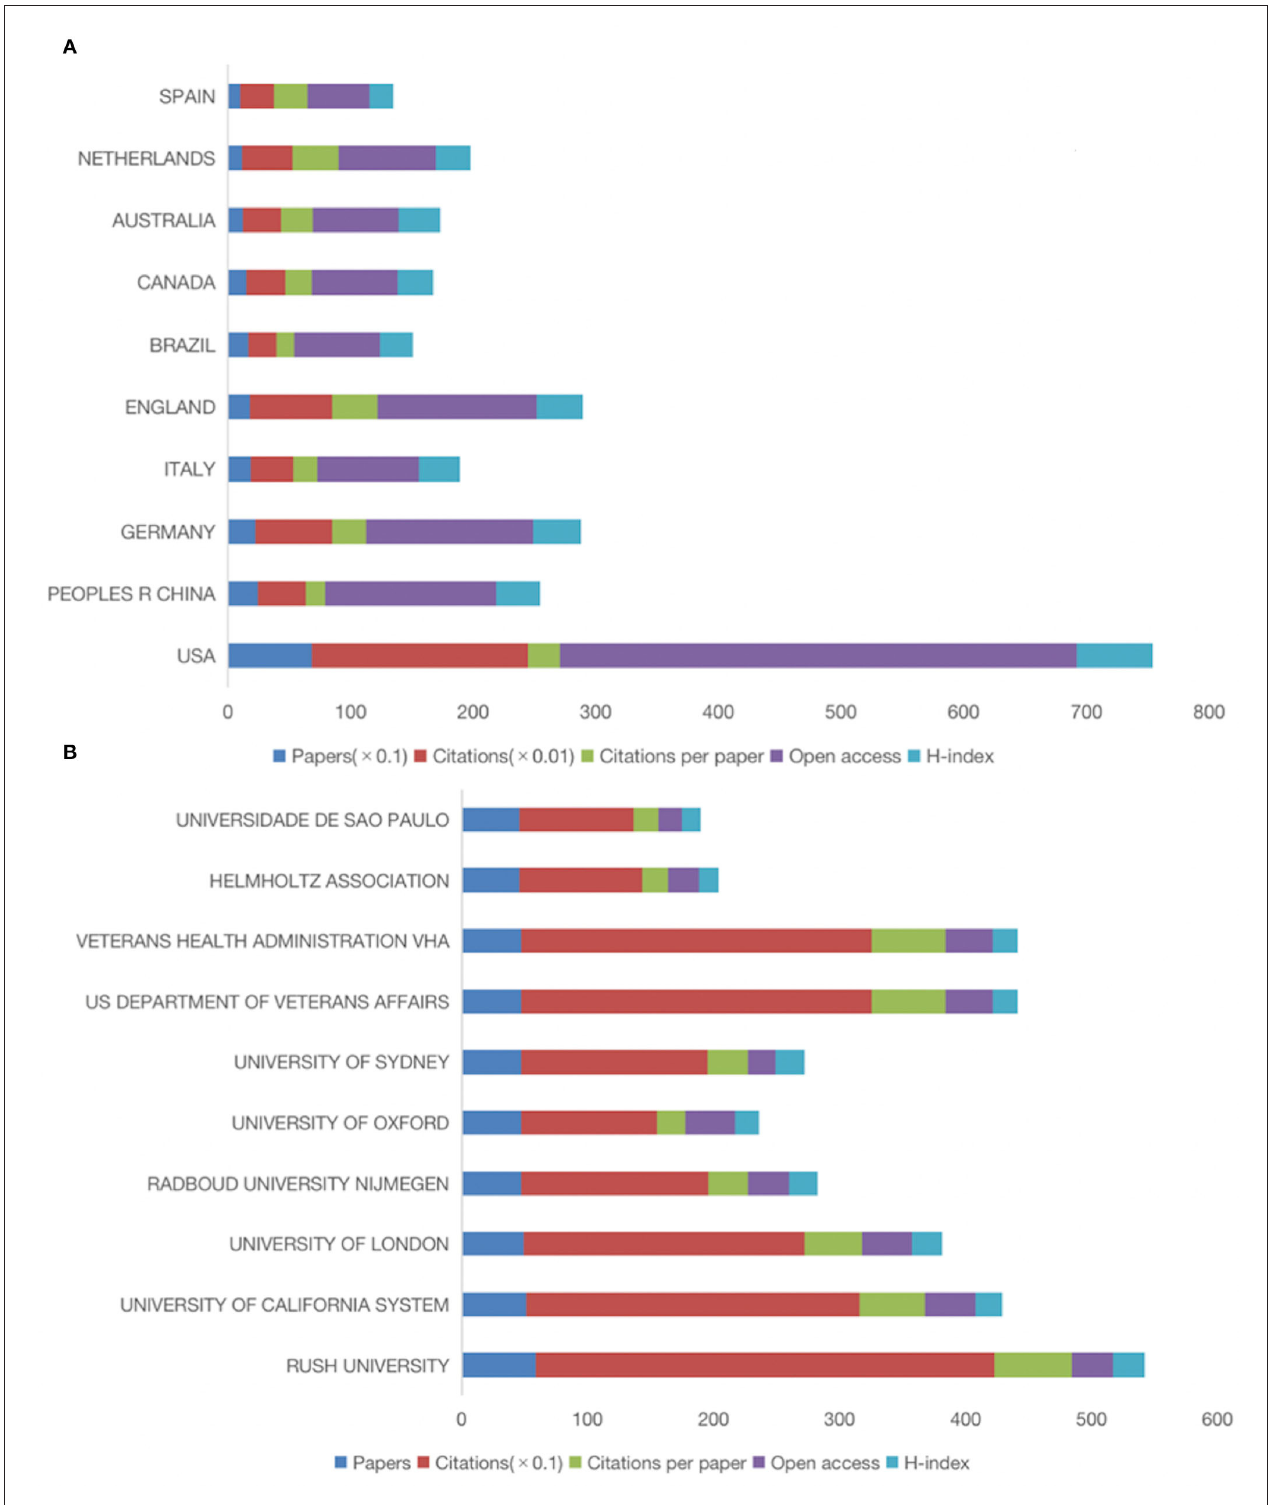
FIGURE 5 | Country and institutional maps of exercise on PD research. (A) Number of papers, citations, citations per paper, number of open access papers, and H-index for the top 10 countries. (B) Number of papers, citations, citations per paper, number of open access papers, and H-index for the top 10 academic